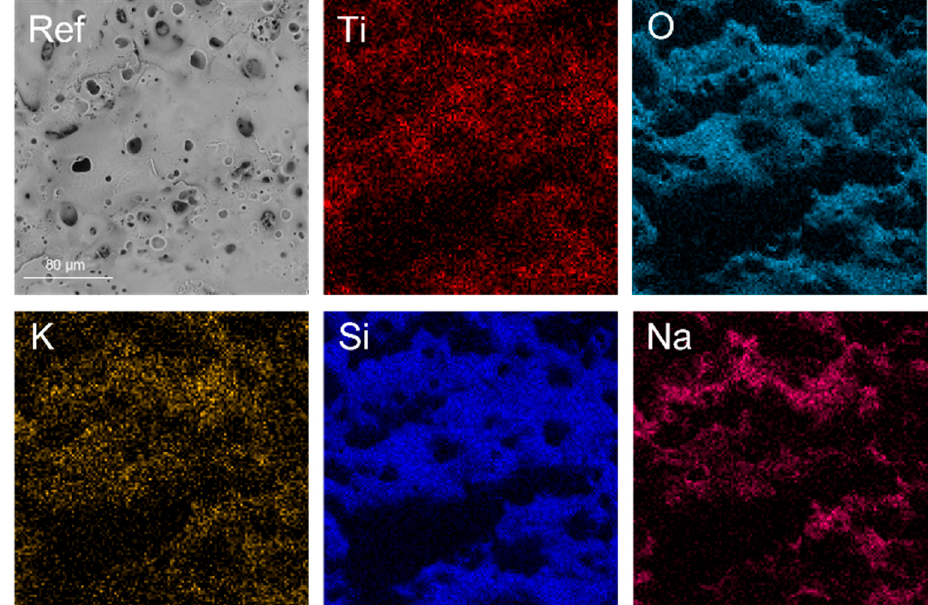
Figure 2. SEM image and EDX mapping of the reference sample.